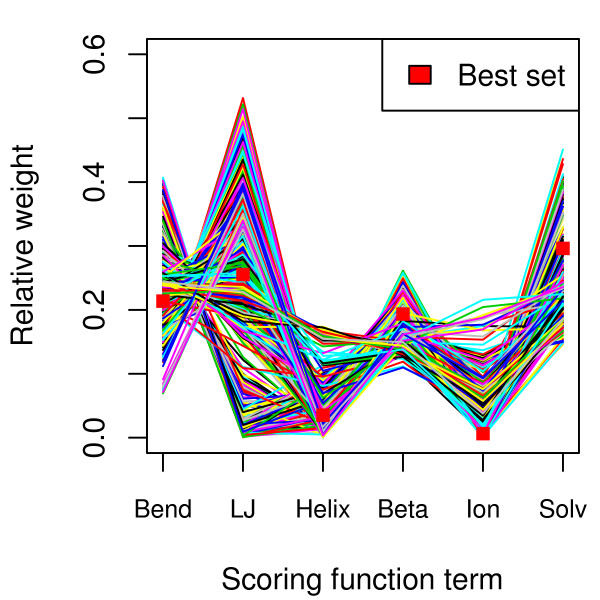
Parameter sets of approximately equally likely term weights for the SAP protein are shown. Each set is represented as a colored line, and the best set is shown as filled red squares. The Cys-Cys term was not included because of the lack of disulfide bridges in the SAP protein, although there is potentially limited information in that term in contrasting with alternative conformations with disulfide bridges.